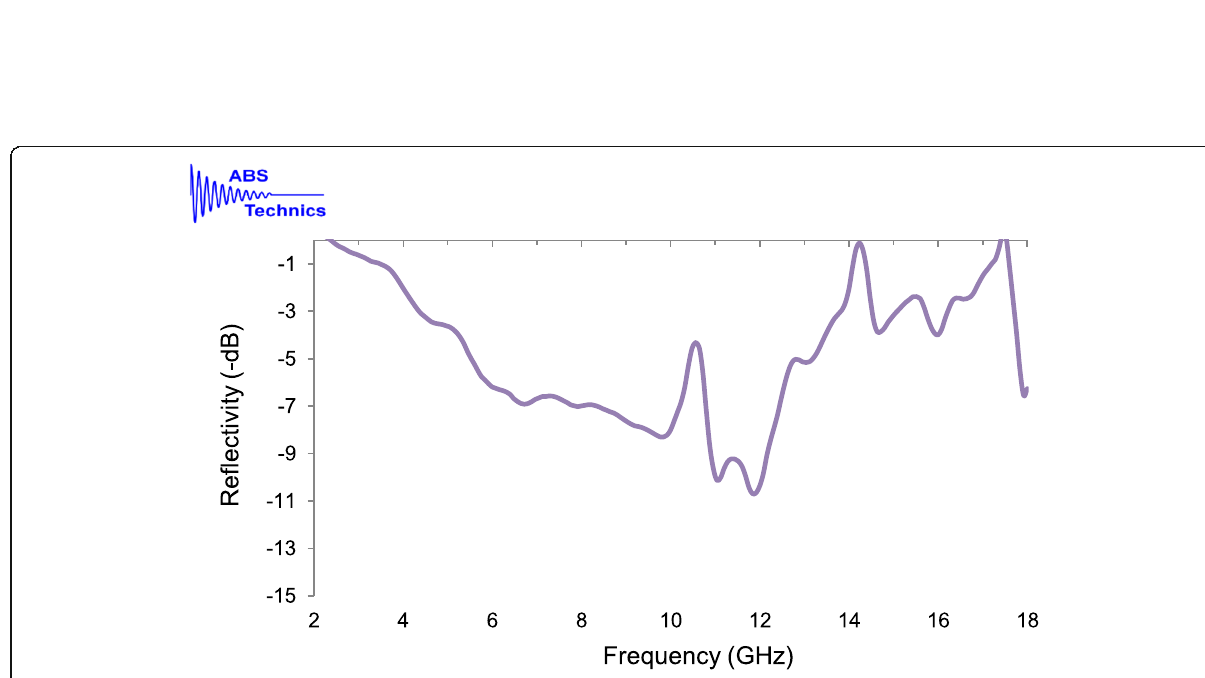
Fig. 6 Measured reflectivity plots at 10° incidence of TE-polarized